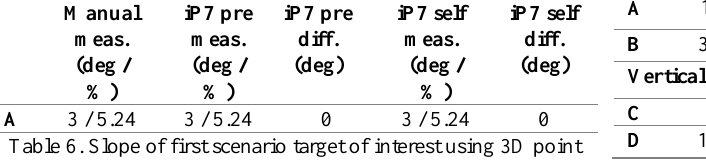
Table 8. Dimensions of steps using 3D point cloud generated with full set of images from iPhone 7; pre-calibrated camera parameters vs self-calibration